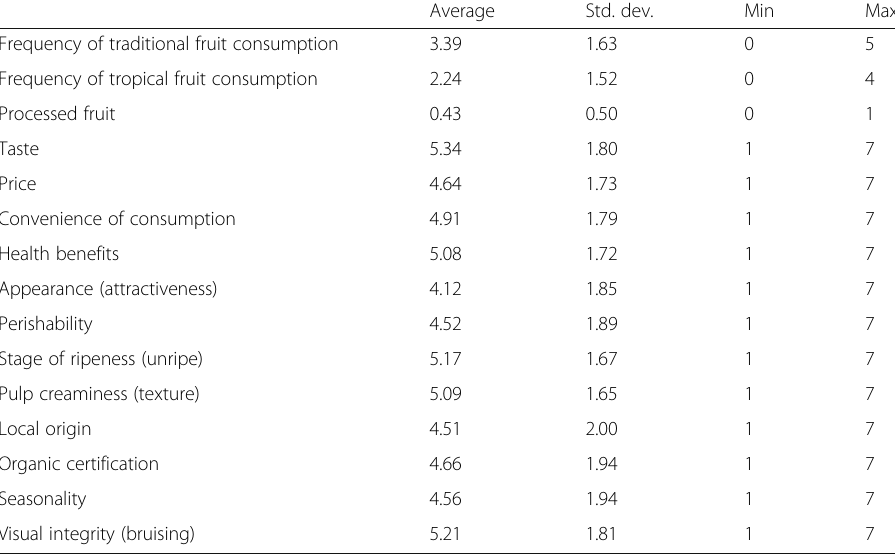
Table 3 Descriptive statistics of the variables implemented in the model Average Std. dev. Min Max Frequency of traditional fruit consumption 3.39